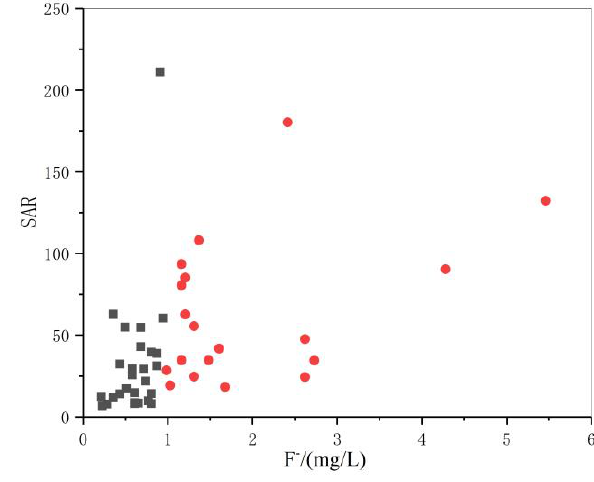
Figure 7. Relationship between ρ[F - ] and the SAR.